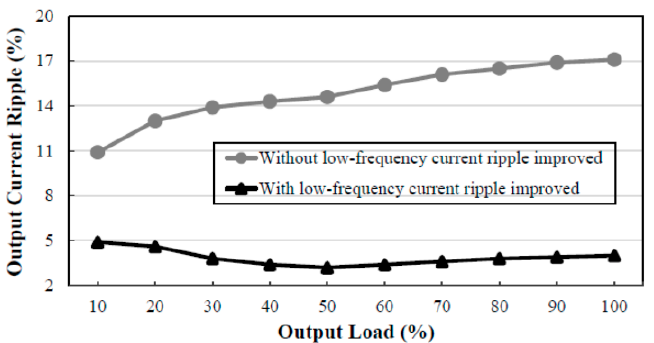
Figure 18. Curve of output current ripple versus output load under 220 V input voltage.